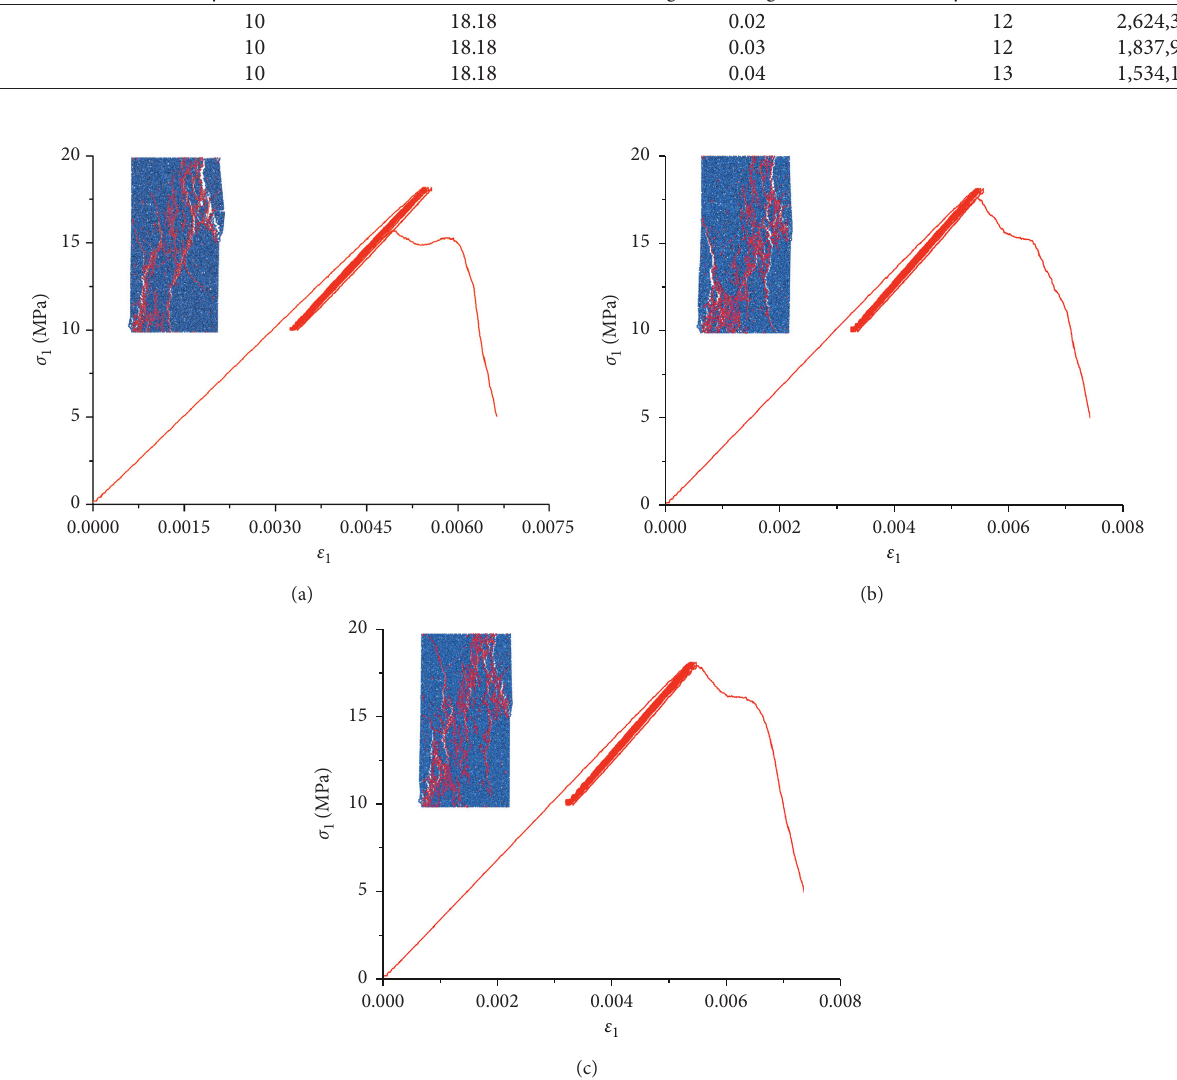
Figure 8: The axial stress- strain curves under different loading-unloading rates: (a) 0.02m/s, (b) 0.03m/s, and (c)